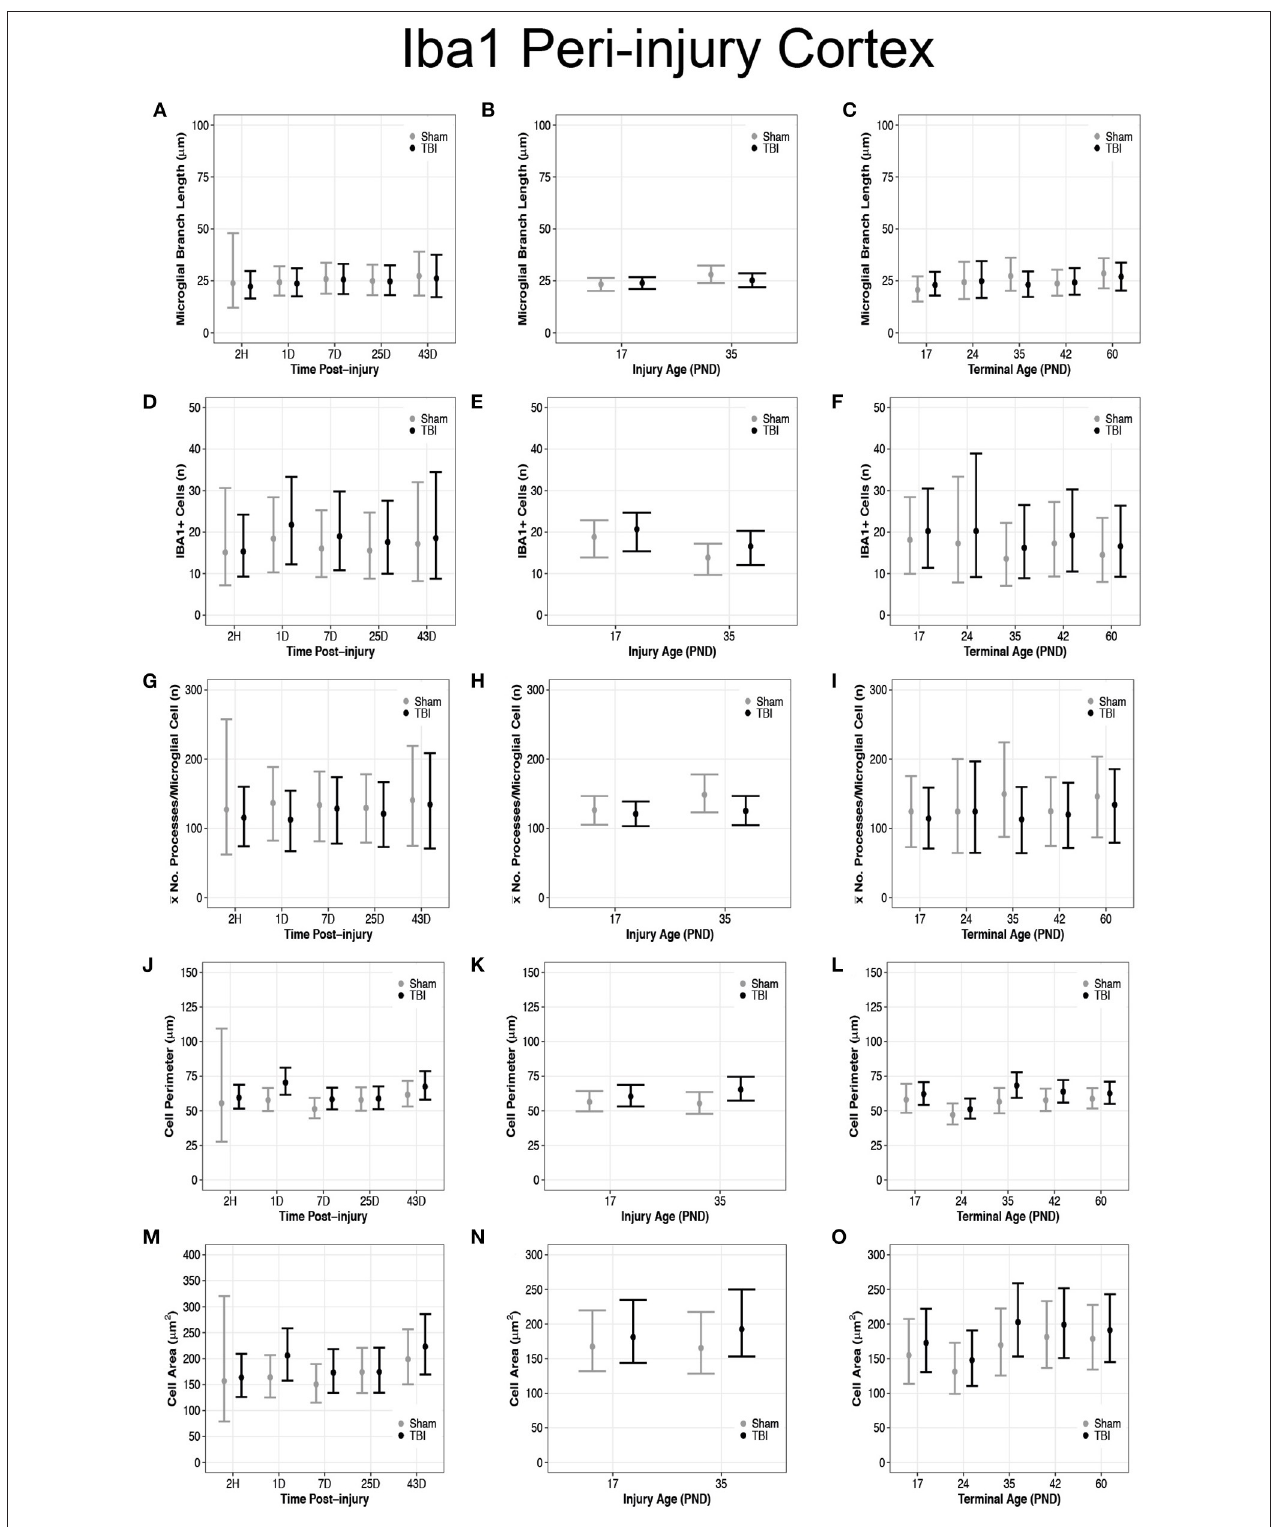
FIGURE 3 | Diffuse TBI activated microglia in the peri-injury cortex of rats injured at PND17 and PND35. Point estimates (posterior means) and corresponding 95% credible intervals (highest posterior density intervals) are presented. (A–C) There were no differences in microglial branch lengths between sham and TBI rats